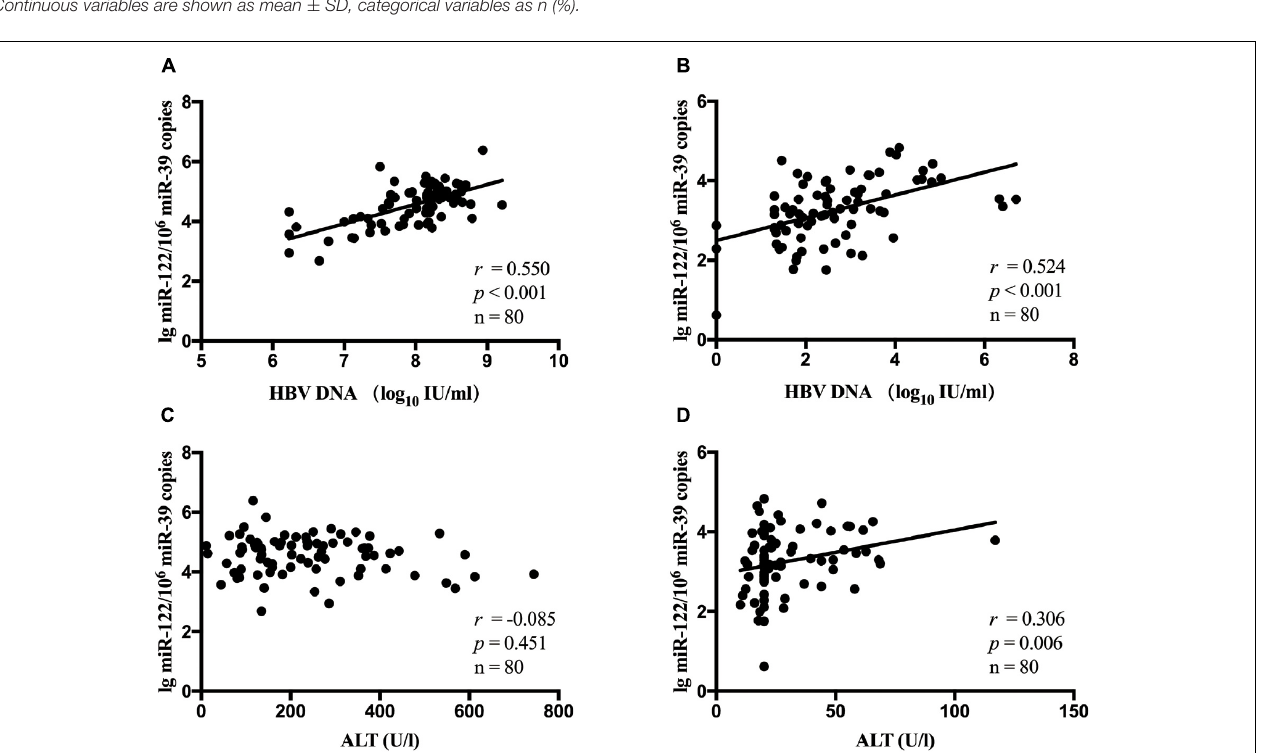
FIGURE 1 | The correlation between serum miR-122 levels, viral loads and ALT levels in all patients. Spearman’s correlations of serum miR-122 levels and HBV DNA levels were conducted at baseline (A) and week 24 (B) . Spearman’s correlations of serum miR-122 levels and ALT levels were conducted at baseline (C) and week 24 (D)